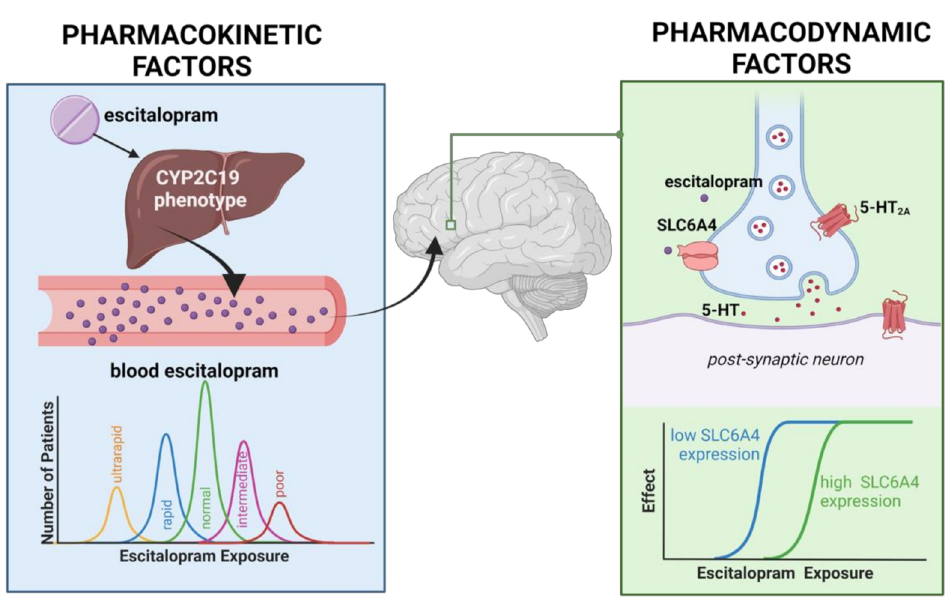
Figure 1. Multiple factors influence the efficacy and side effect profile of escitalopram in anxious adolescents. 5-HT, serotonin; SLC6A4 , serotonin transporter. The current study primarily focuses on pharmacokinetic factors that impact response and tolerability (blue box), although, secondarily, pharmacodynamic influences (green box) are examined. Image created using